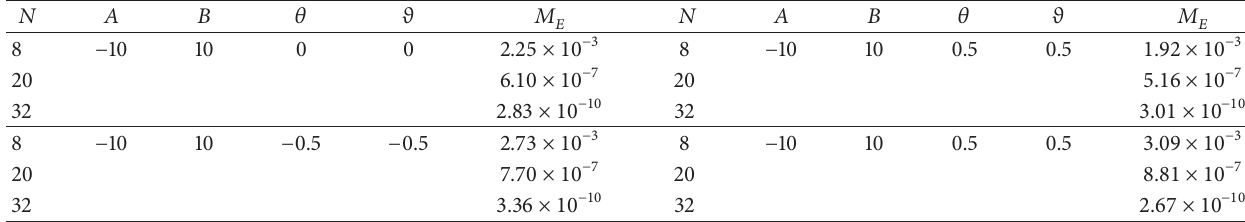
Table 6: Maximum absolute errors with various choices of 𝑁 , 𝜃 , and 𝜗 with 𝜏 = 0.5 for Example 4.